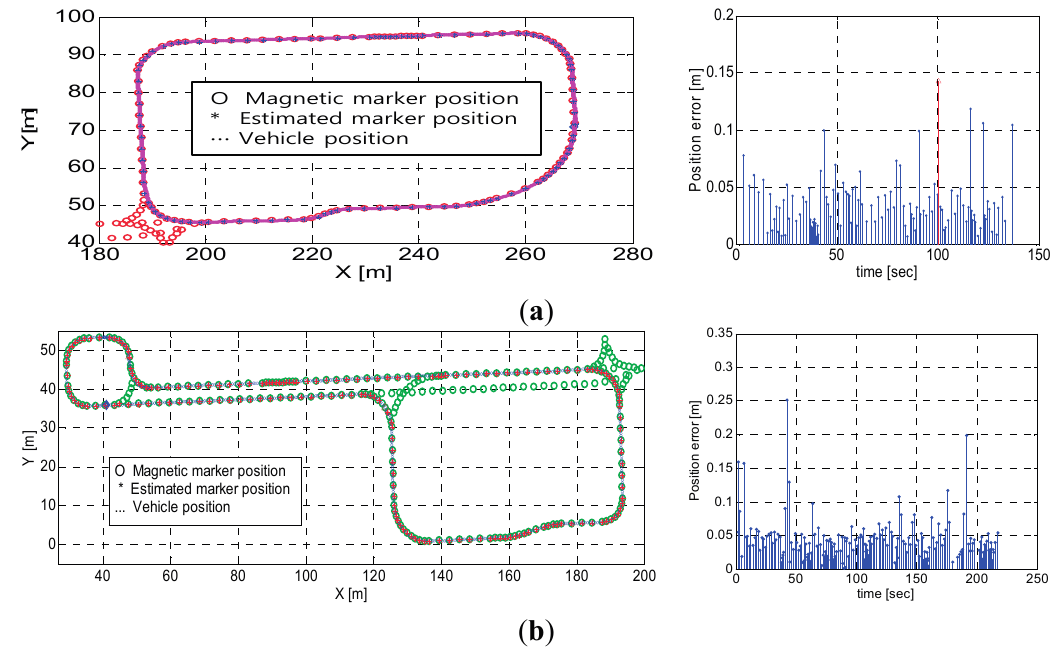
Figure 13. Estimation results ( i.e ., comparison of estimated positions with absolute positions of magnetic markers and their estimation errors) in practical operation of 2 m/s on average for validation of the algorithm at different loops of the test route with a length of ( a ) 237.96 m and ( b ) 405 m, respectively.